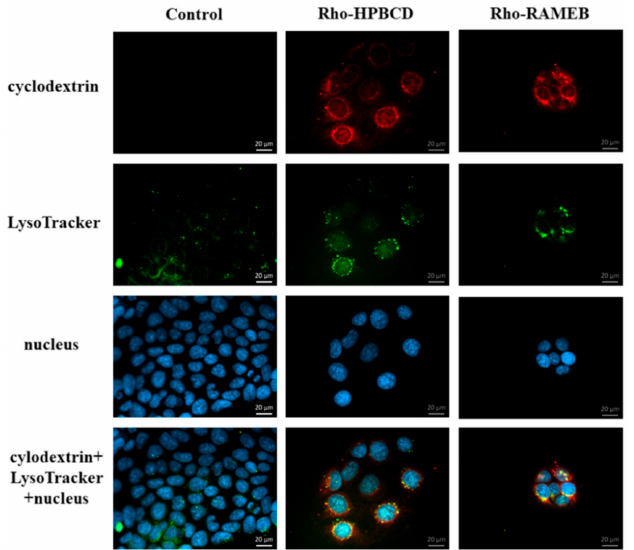
Figure 8. Fluorescence microscopic images of Caco-2 cells after investigation of lysosomes. Rho- HPBCD and Rho-RAMEB ( red ) are able to enter the lysosomes ( green ). Colocalization appears as yellow pixels on the images.